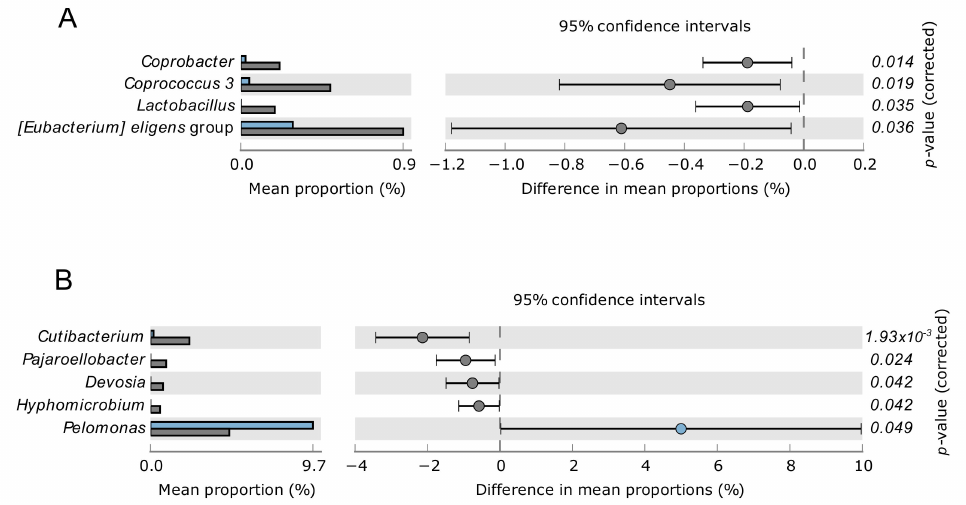
Figure 3. Relative changes of gut ( A ) and blood ( B ) bacterial taxa at the genus/family level in chronic kidney disease patients on peritoneal dialysis comparing patients with vascular calcification (grey bars) with patients without vascular calcification (blue bars).